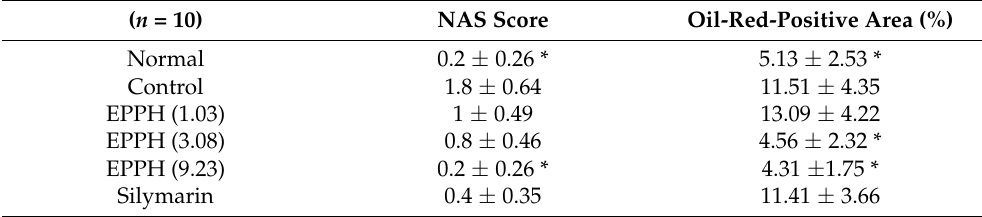
Table 2. Analysis of